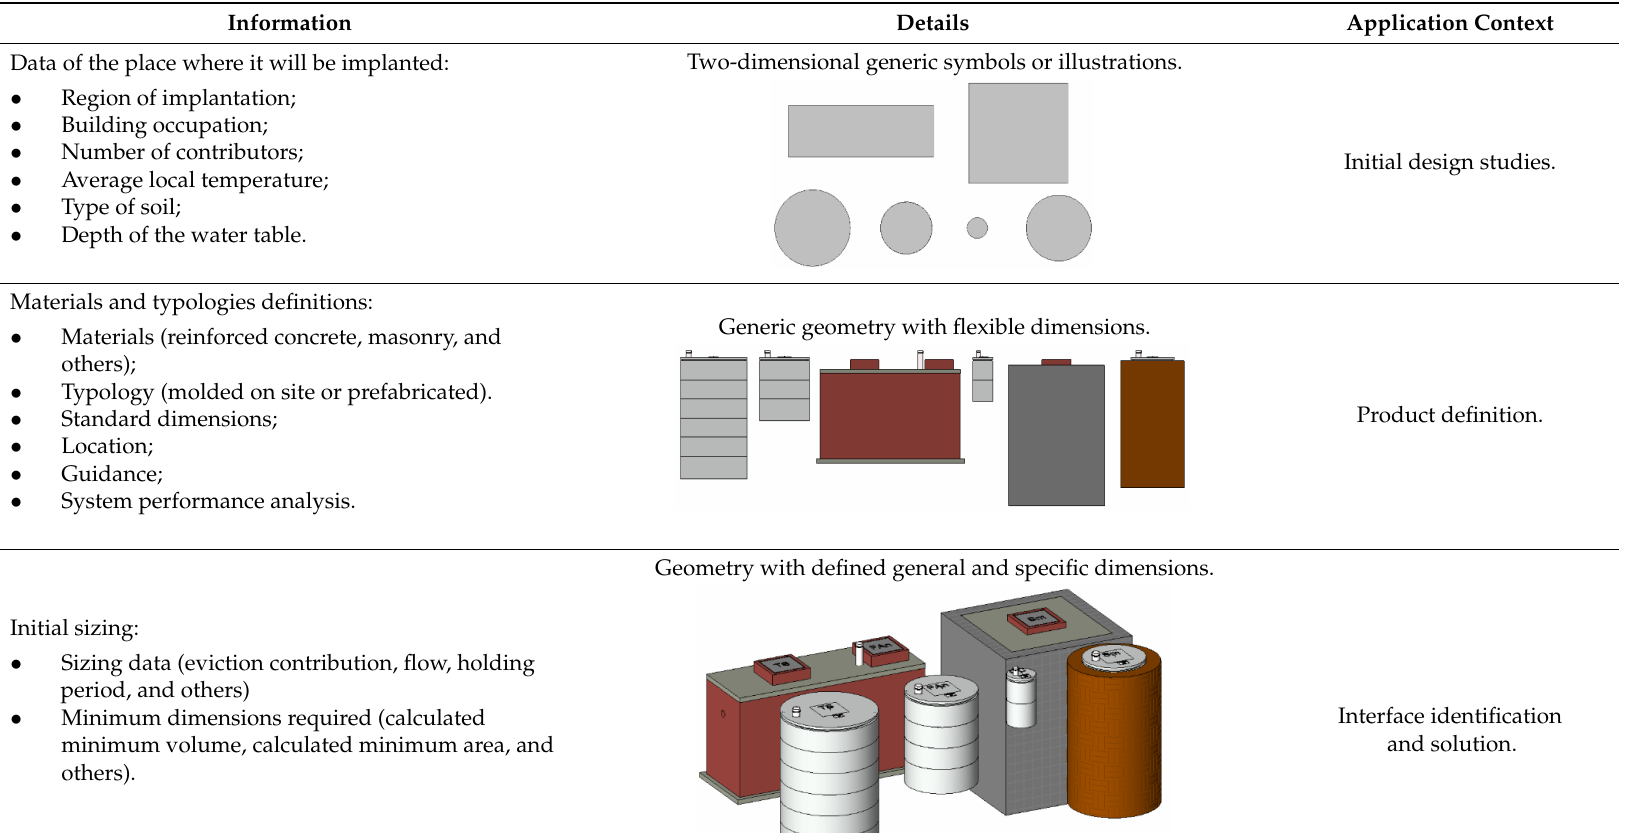
Table 2. Level of development (LOD) on learning specifications for